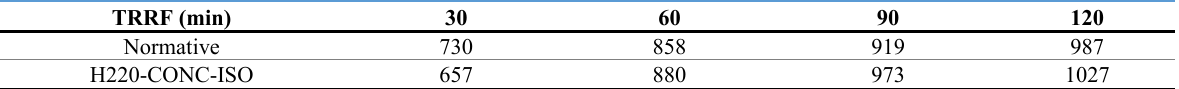
Table 3. Comparison of theoretical temperatures and numerical model on steel profile flanges for composite columns with uniform heating.